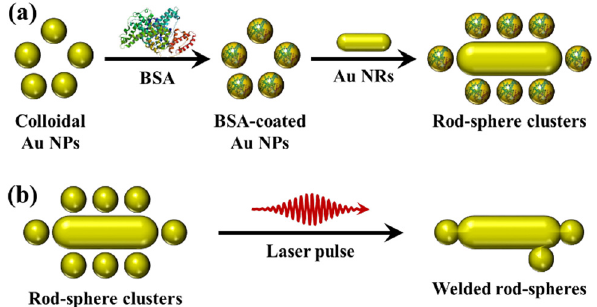
Figure 1: Schematic representation of (a) synthesis of Au rod – sphere nanoclusters and (b) welding of those nanoclusters by irradiation with fs laser